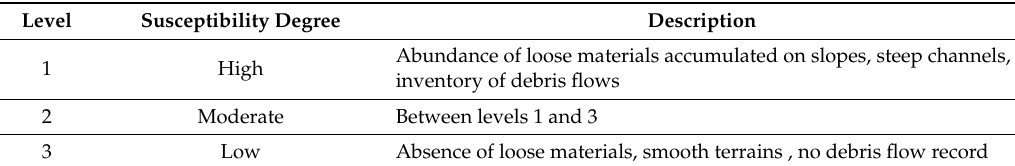
Table 6. Principles for assessing the actual condition of debris flow gullies.